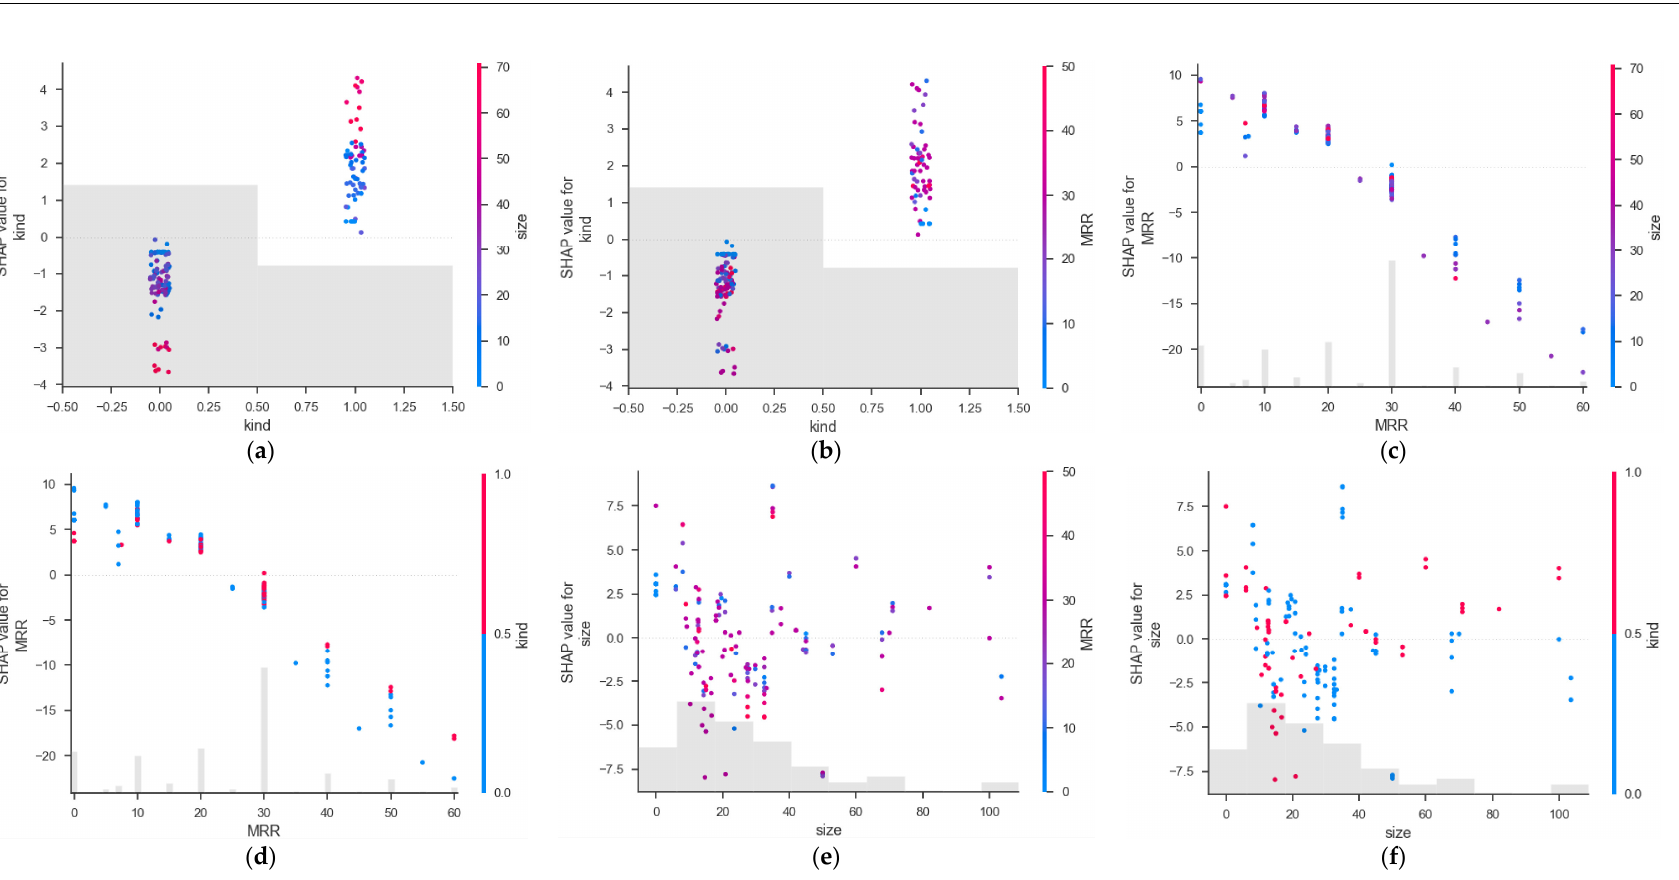
Figure 13. Feature dependency graph. Feature dependence plots for ( a , b ) kind; ( c , d ) mass replacement rate; ( e , f ) size.